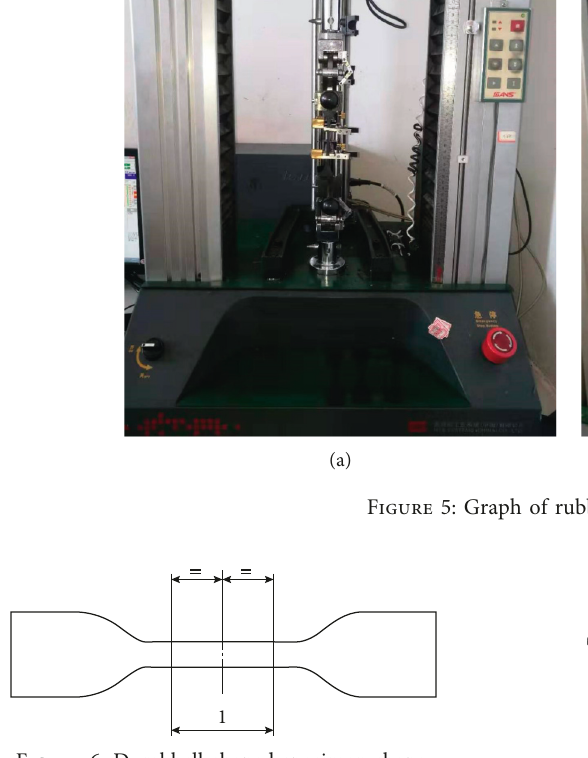
Figure 8: Diagram of the plate strip head